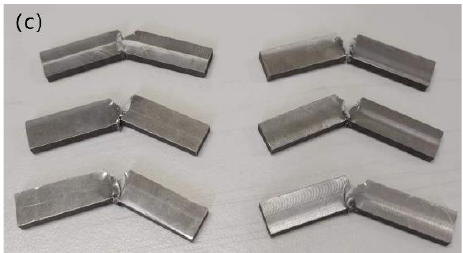
Figure 4. Schematic diagram of tensile and impact sampling ( a ) Sampling location; ( b ) Tensile test specimen; ( c ) Impact specimen.